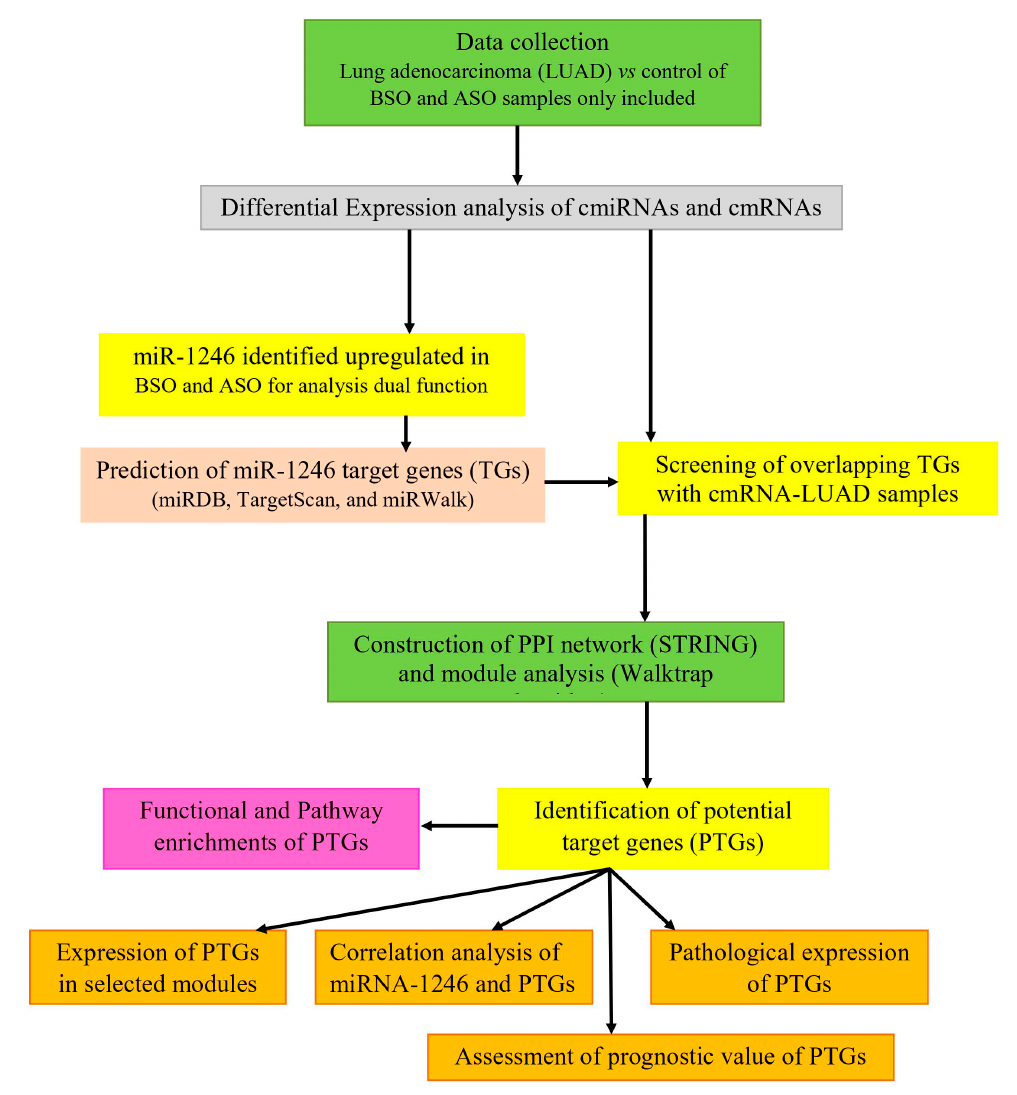
Figure 1. Schematic illustration of the study.